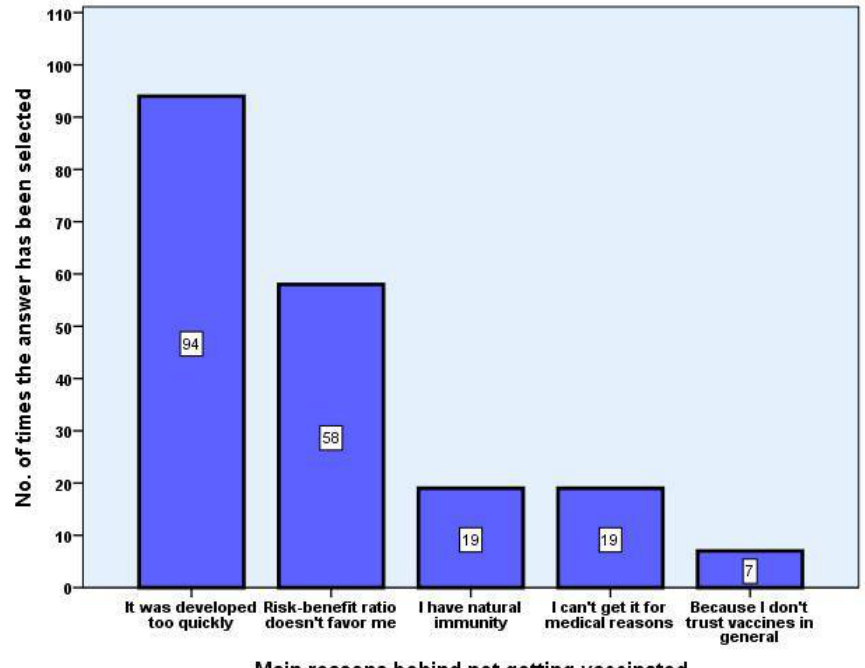
Figure 2. Main reasons for refusal of EU-approved COVID-19 vaccines. After being presented with several, the top five most frequent answers chosen from a pre-established list were visually generated as a bar plot to assess their frequency amongst replies.